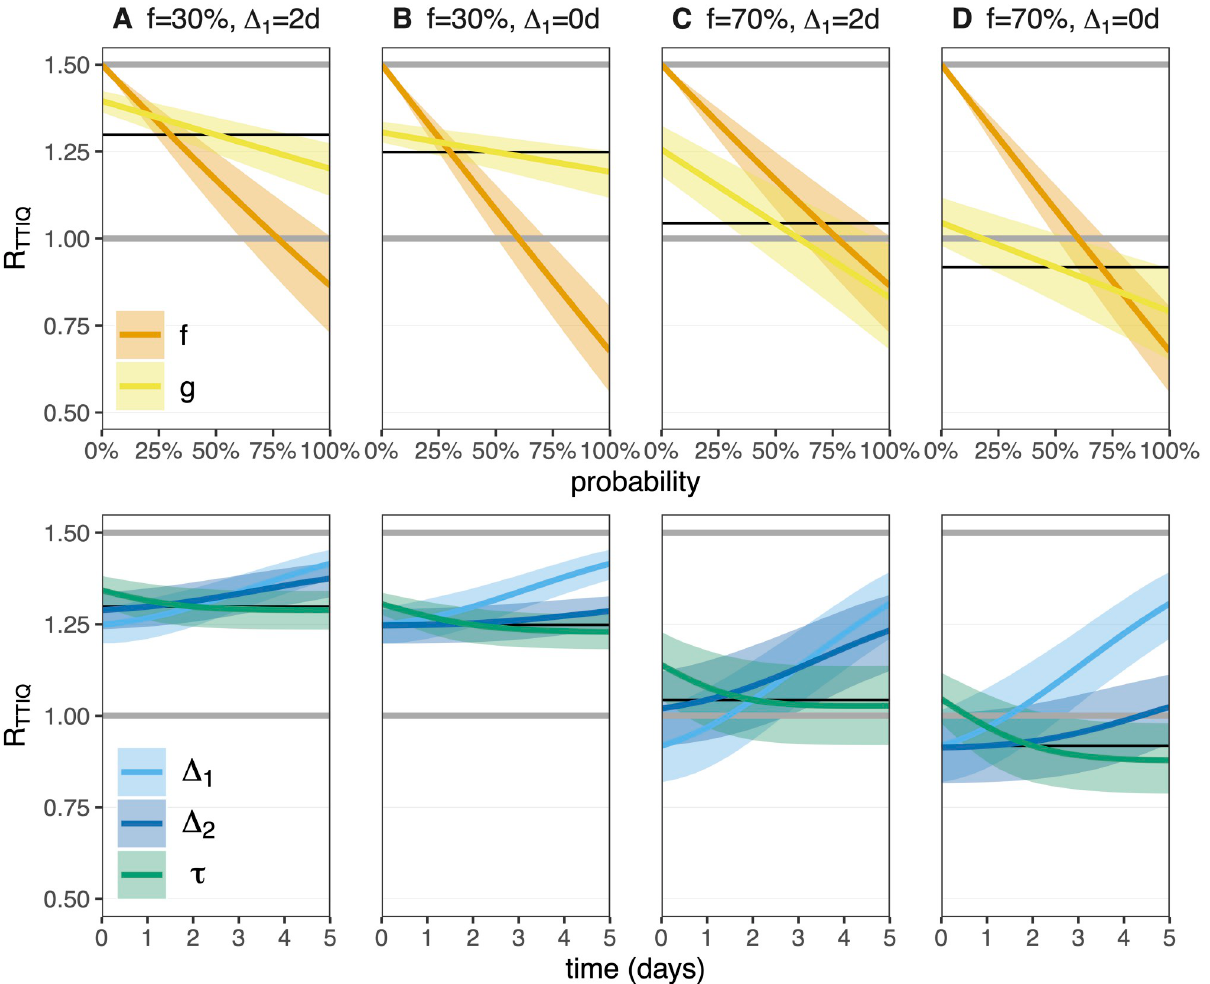
Fig 4. The response of the reproductive number R TTIQ to single TTIQ parameter perturbations. We set the baseline R = 1.5 throughout, which is the intensity of the epidemic in the absence of any TTIQ intervention. We consider four focal TTIQ parameter combinations, with f 2 {30%, 70%}, Δ 1 2 {0, 2} days, g = 50%, Δ 2 = 1 day, and τ = 2 days. R TTIQ for the focal parameter sets are shown as thin black lines. With f = 0 (no TTIQ) we expect R TTIQ = R (upper grey line). We then vary each TTIQ parameter individually, keeping the remaining four parameters fixed at the focal values. The upper panel shows the probability parameters f and g , while the lower panel shows the parameters which carry units of time (days). The critical threshold for controlling an epidemic is R TTIQ = 1 (lower grey line). We fix the fraction of transmission that is attributed to asymptomatic infections to α = 20%. A sensitivity analysis to α is shown in Fig I in S2 Appendix. Asymptomatic individuals are not tested or isolated, but are subject to quarantine after contact tracing. Data provided in S1